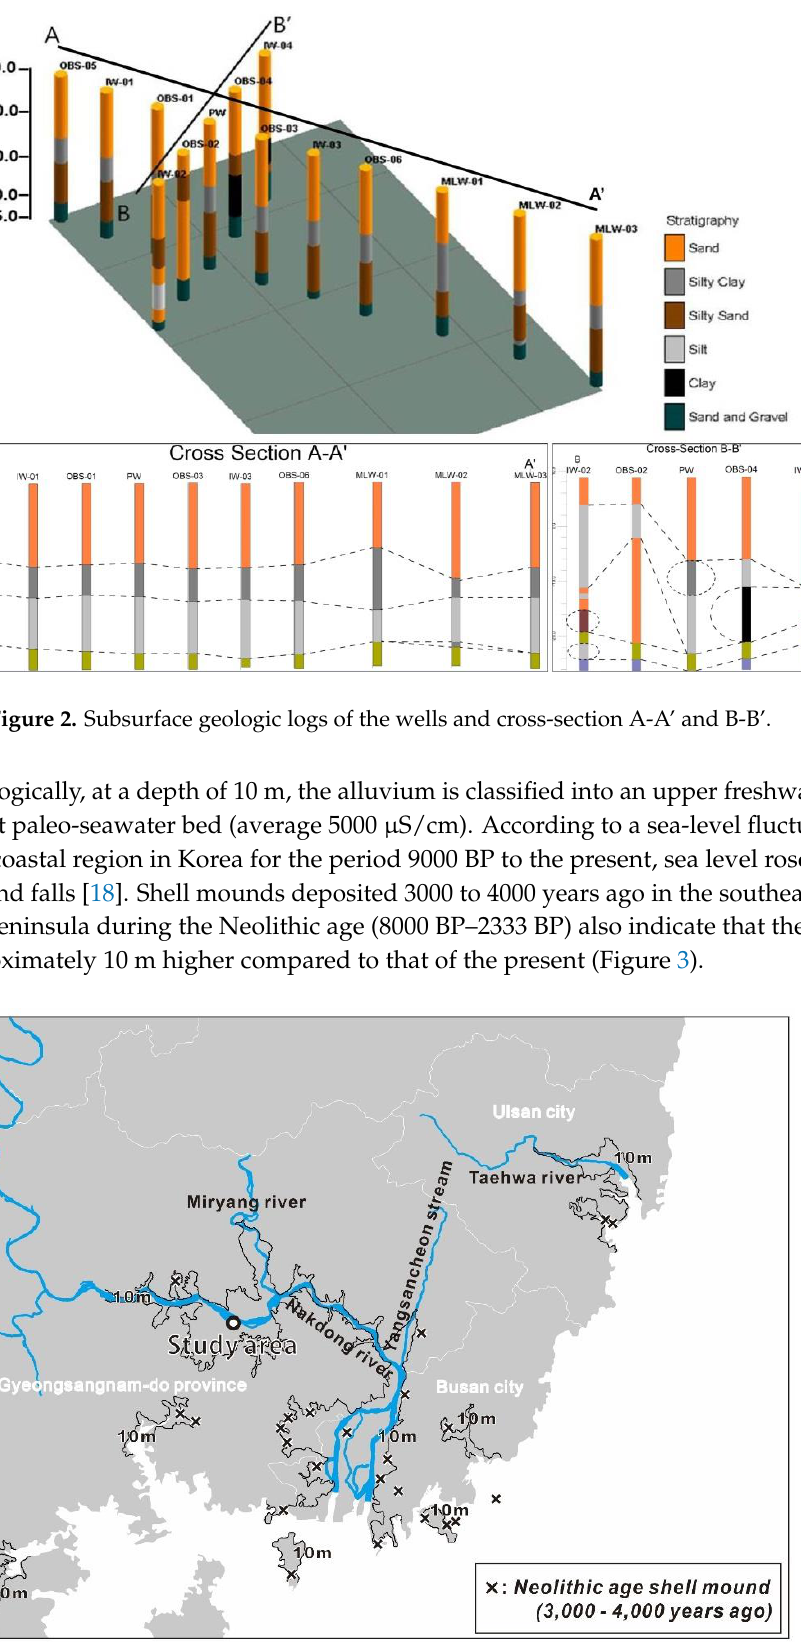
Figure 3. Location of shell mounds deposited 3000 to 4000 years ago.